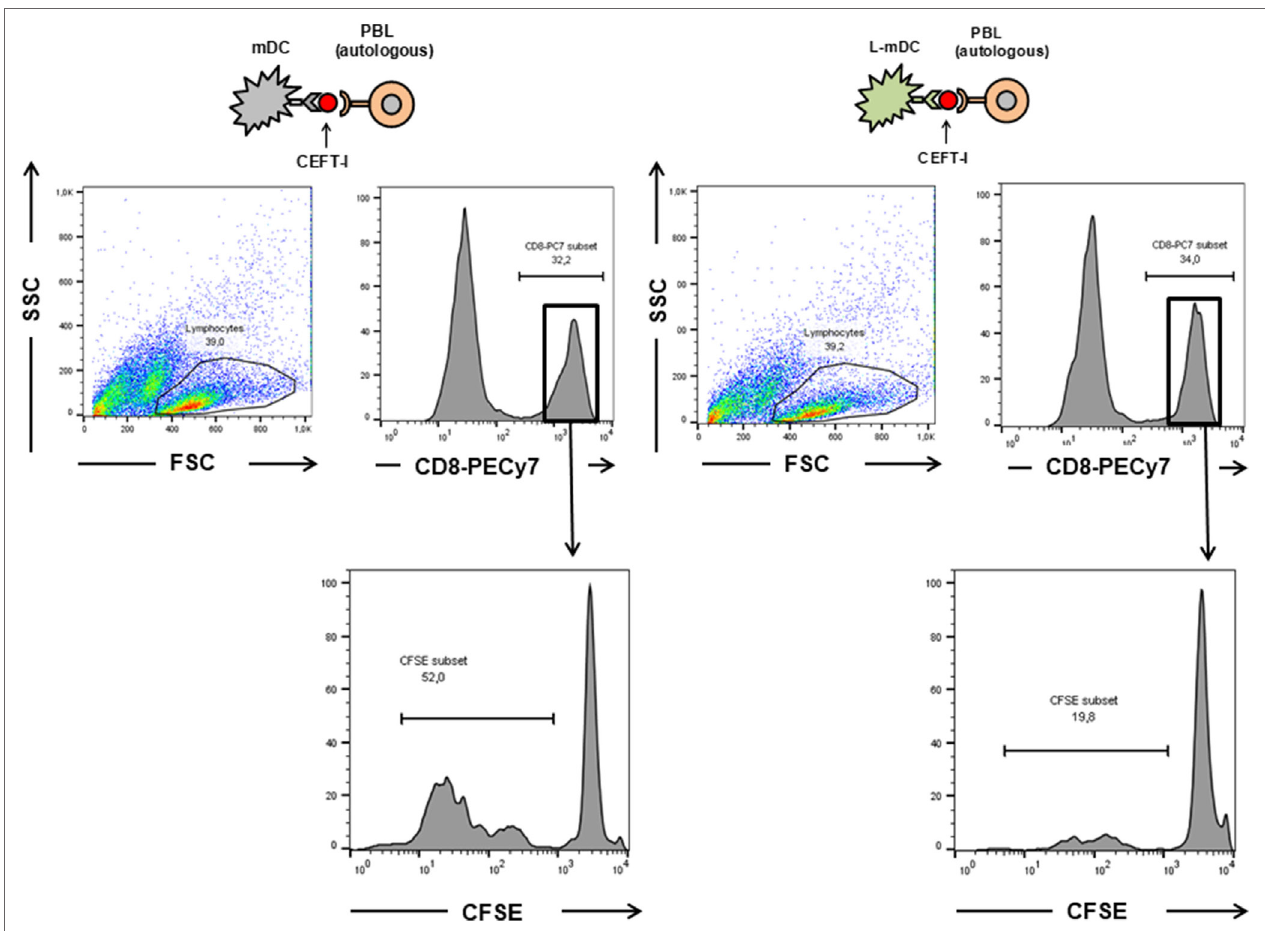
FigUre 9 | The proliferation of CD8 + antigen-specific T-cells is reduced upon L-mDC stimulation. Autologous PBLs were co cultured with mDC or L-mDC previously incubated with CEFT-I peptide pool. The upper panel shows the region gated for the analysis of CFSE dilution. The lower panel shows the proliferation (CFSE dilution) of the PBLs after 14 days of